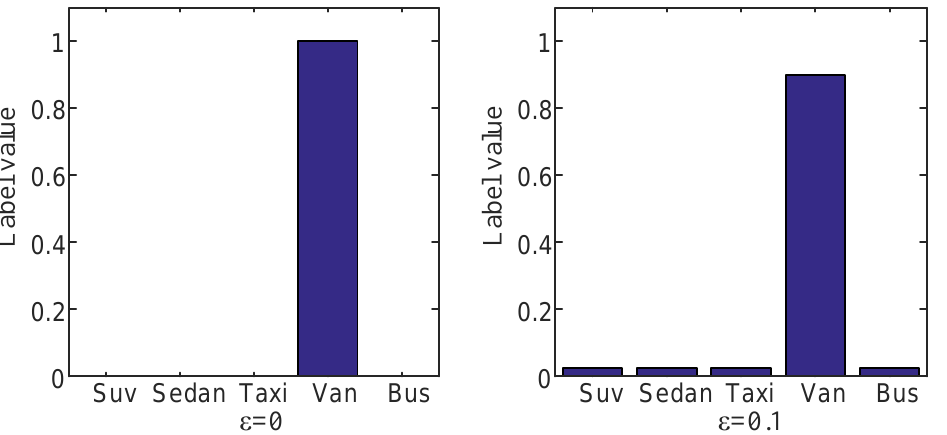
Figure 5. Schematic diagram of Label Smoothing Regularization.